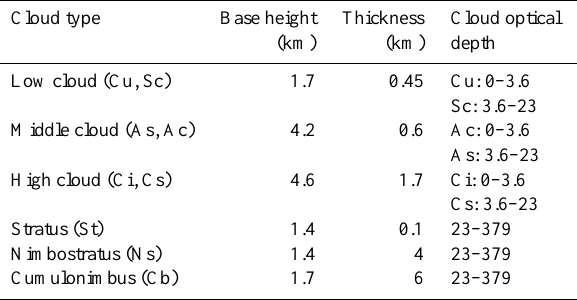
Table 2. Properties of cloud types. Base height and thickness are from Liou (1976), and cloud optical depth are from Rossow and Schiffer (1999). Cu: cumulus, Sc: stratocumulus, As: altostratus, Ac: altocumulus, Ci: cirrus, Cs: